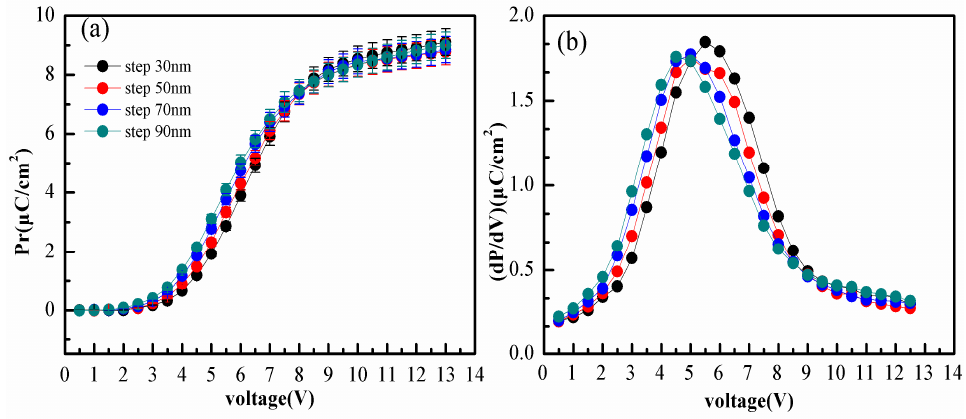
Figure 6. P r and the first derivative value of P r . ( a ) P r as a function of the driver voltage for the films with varying step heights; ( b ) The first derivative value as a function of voltage for the films with varying step heights.